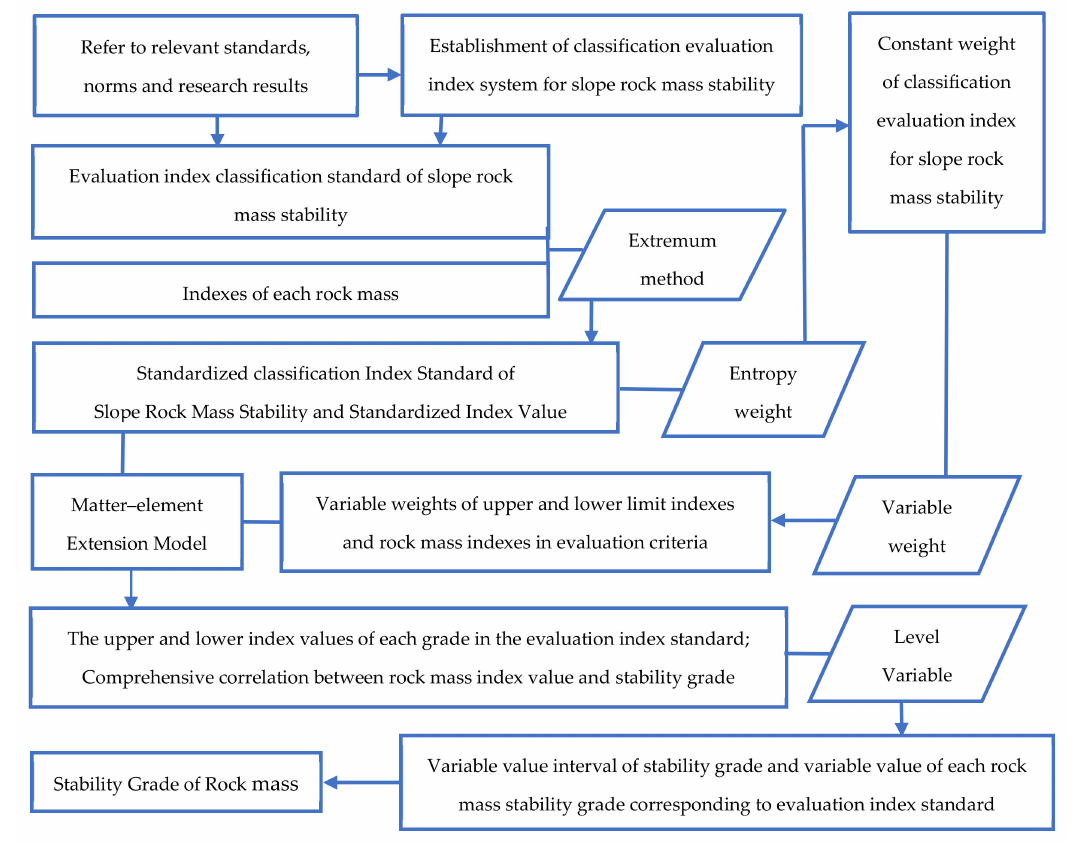
Figure 2. Evaluation process of the variable weight matter–element extension model for the classification of the slope rock mass